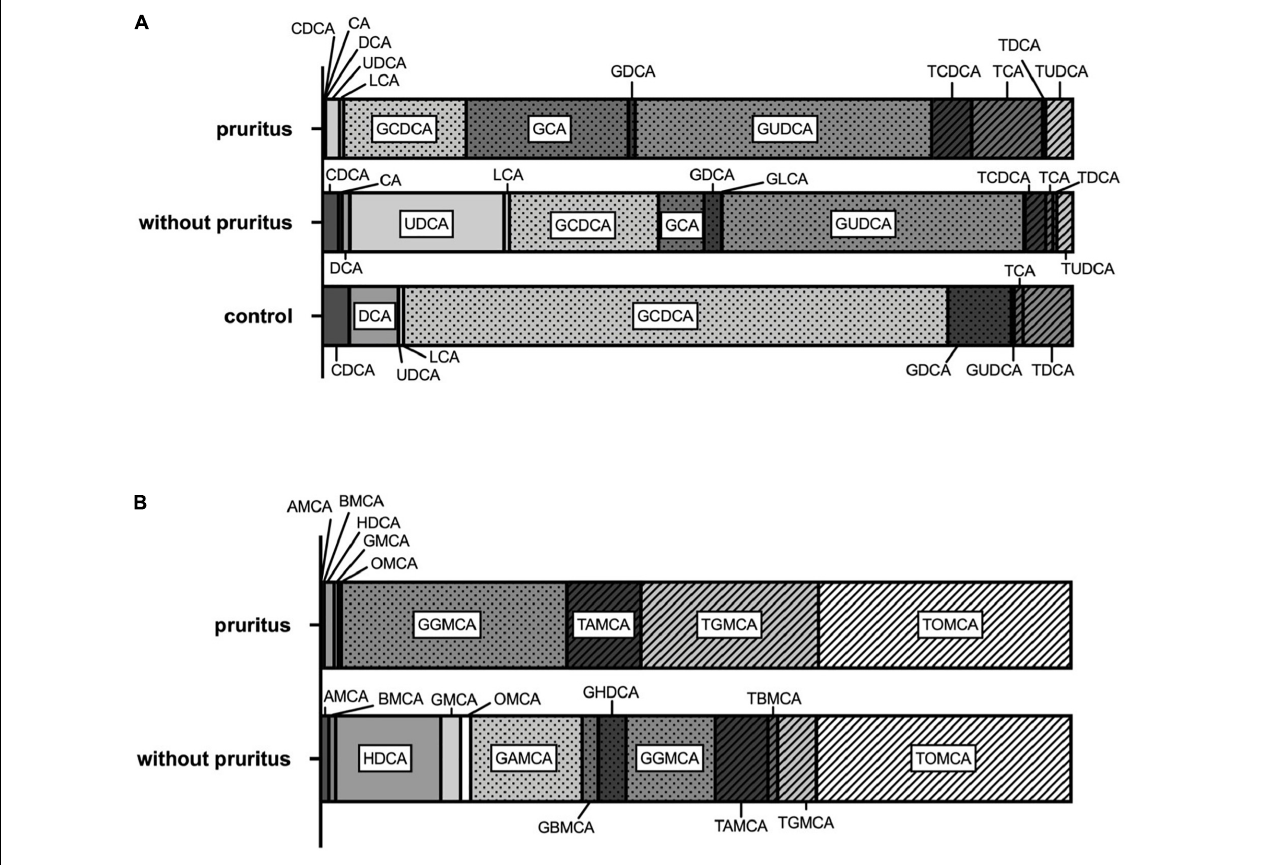
FIGURE 3 | Bile acid profiles (A) and muricholic acid profiles (B) in ASC patients with and without pruritus.